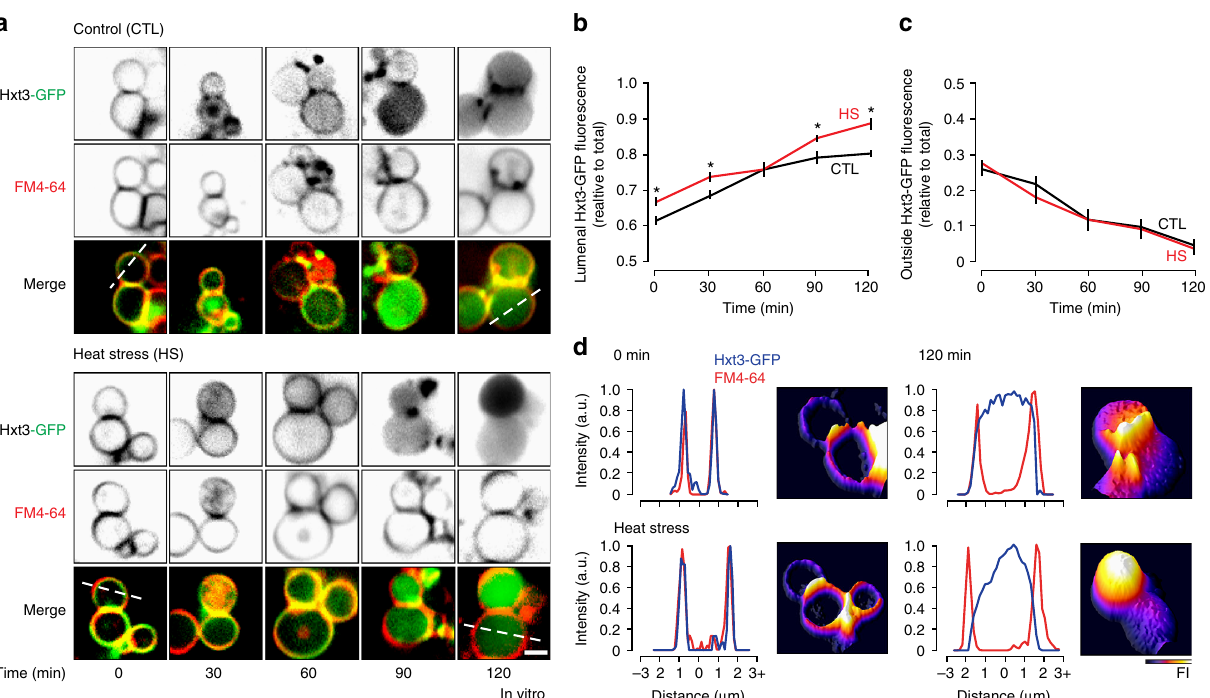
Fig. 6 Hxt3-GFP is cleared from vacuole membranes during fusion in vitro. a Fluorescence micrographs of vacuoles isolated from wild type cells expressing Hxt3-GFP acquired over the course of the in vitro fusion reaction in the absence (control; left) or presence (right) of heat stress. Vacuole membranes were stained with FM4 – 64. Scale bar, 2 µ m. b , c Using micrographic data shown in a , averages ± S.E.M. of Hxt3-GFP fl uorescence intensity were measured within the lumen ( b ) or outside membrane ( c ) of vacuoles isolated from wild-type cells over the course of the fusion reaction with or without heat stress. * P < 0.05, as compared to CTL by t -test. n = 5 experiments whereby a total of 89, 88, 118, 100, 85 vacuoles were analyzed under CTL conditions, and 85, 108, 116, 110, 108 vacuoles were analyzed after HS, at 0, 30, 60, 90, 120 min, respectively. d Line plots of Hxt3-GFP and FM4 – 64 fl uorescence, and 3- dimensional GFP fl uorescence intensity (FI) plots of from micrographs in a showing vacuoles isolated from wild type cells before (0 min) and after 120 min of fusion after heat stress, to indicate that Hxt3-GFP is completely cleared from vacuole membranes over time in